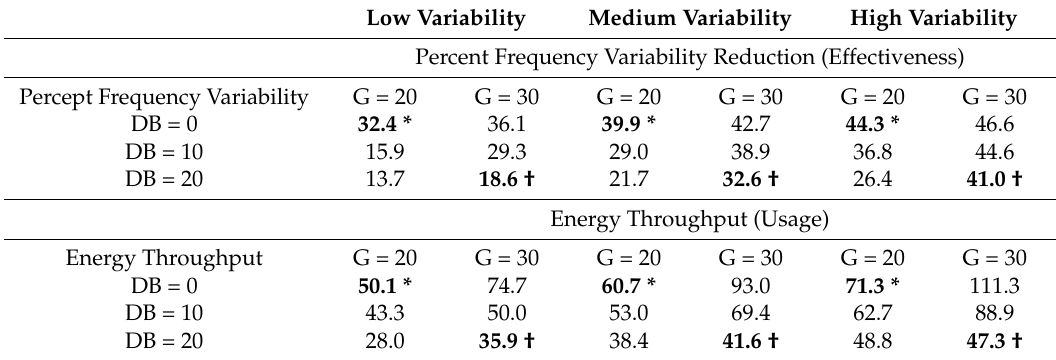
Table 1. Top: The average percent reduction in frequency variability and Bottom: Energy throughput of the BESS under different control algorithm parameter sets and for Low (12 mHz), Medium (16 mHz), and High (20 mHz) background frequency variability regimes. “G” is short-hand for Gain, while “DB” stands for Dead-Band. † and * denote exceptional results that will be discussed further in the following paragraph. Low Variability Medium Variability High Variability Percent Frequency Variability Reduction (Effectiveness) Percept Frequency Variability G =